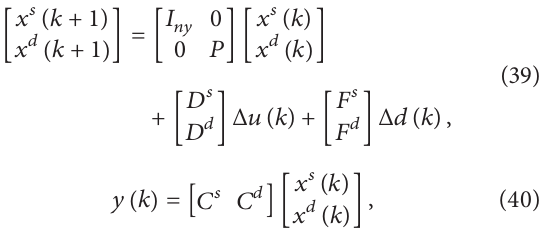
where A r = Φ 𝑇 𝑛 A Φ 𝑛 , B r = Φ 𝑇 𝑛 B , and F r = Φ 𝑇 𝑛 F . The initial condition for 𝑎(𝑡) reads as 𝑎(0) = 0